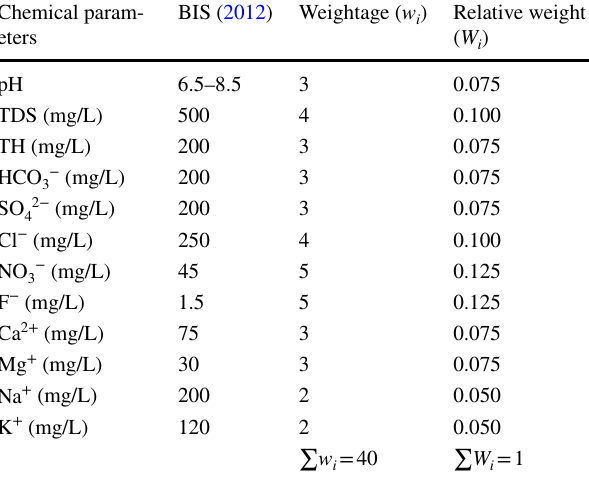
Table 4 Relative weight of hydrochemical parameters Chemical param‑